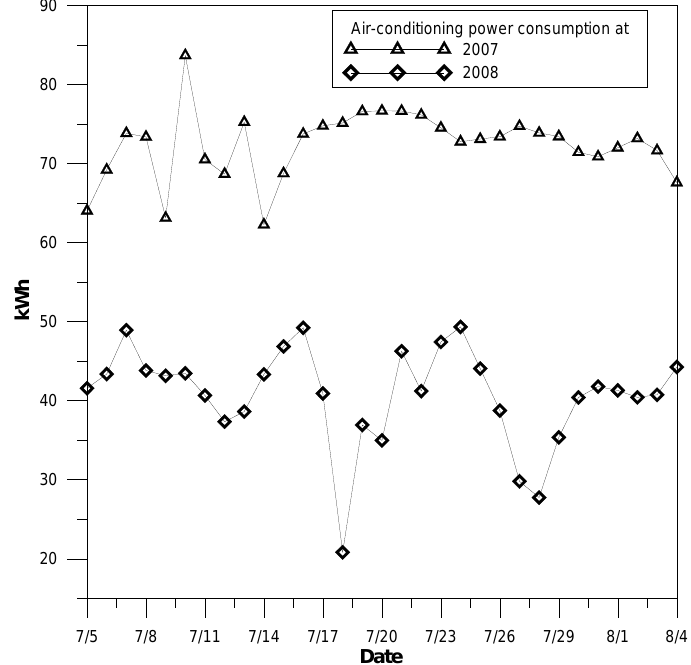
Figure 10. The electrical power consumption plot of air conditioning with and without PMV control based on the feedback of energy harvesting sensor